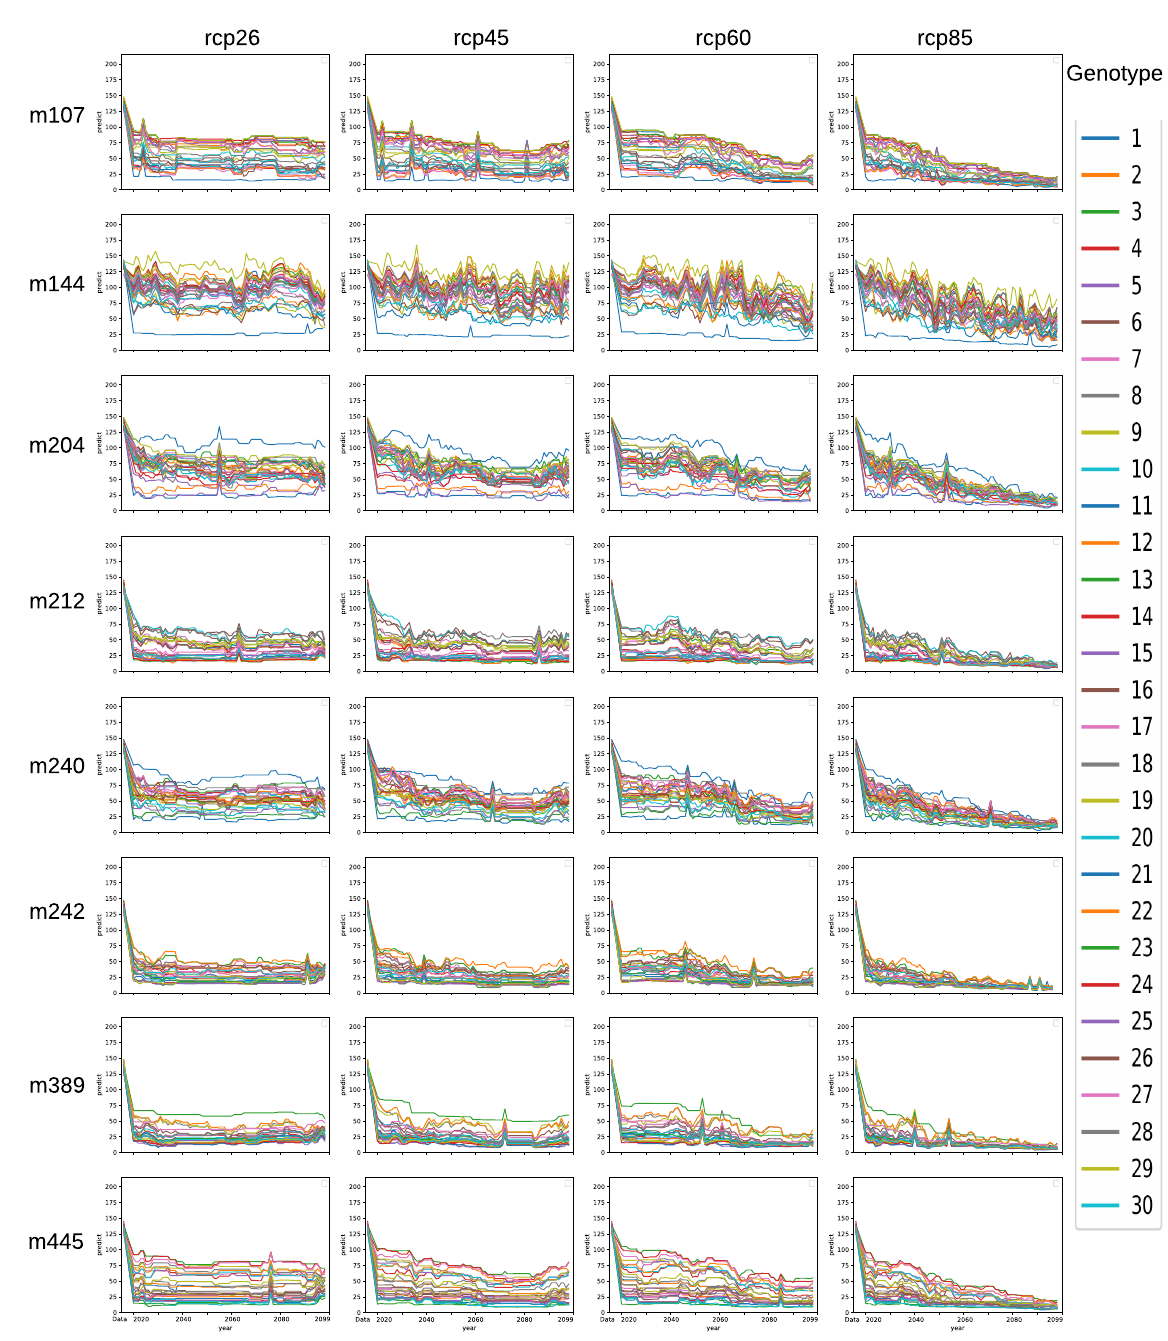
Figure 12. Forecast for time to flowering for 30 genotypes for years from year 2021 to 2099 in Ankara and for sowing date 294 DOY. Each column corresponds to one representative carbon dioxide concentration profile and each row corresponds to one of the ensemble model. The left-most point for each curve corresponds to the time to flowering in the data